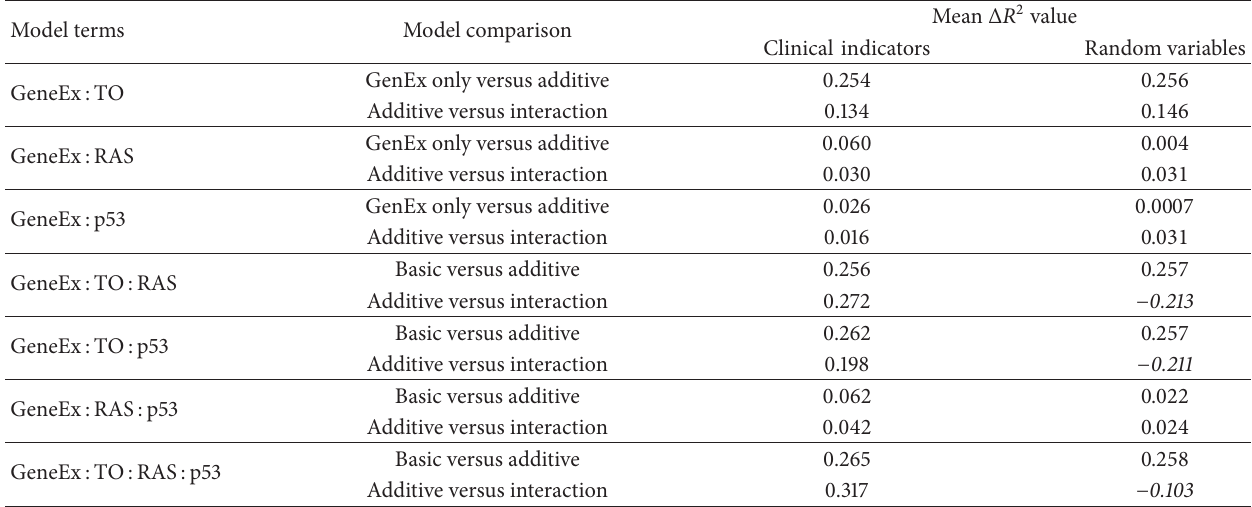
Table 3: Change in Adj- 𝑅 2 value obtained by adding terms and complexity to the linear model. Results obtained with clinical indicators TO, RAS, and p53 are compared to Adj- 𝑅 2 values obtained using random variable for each indicator.